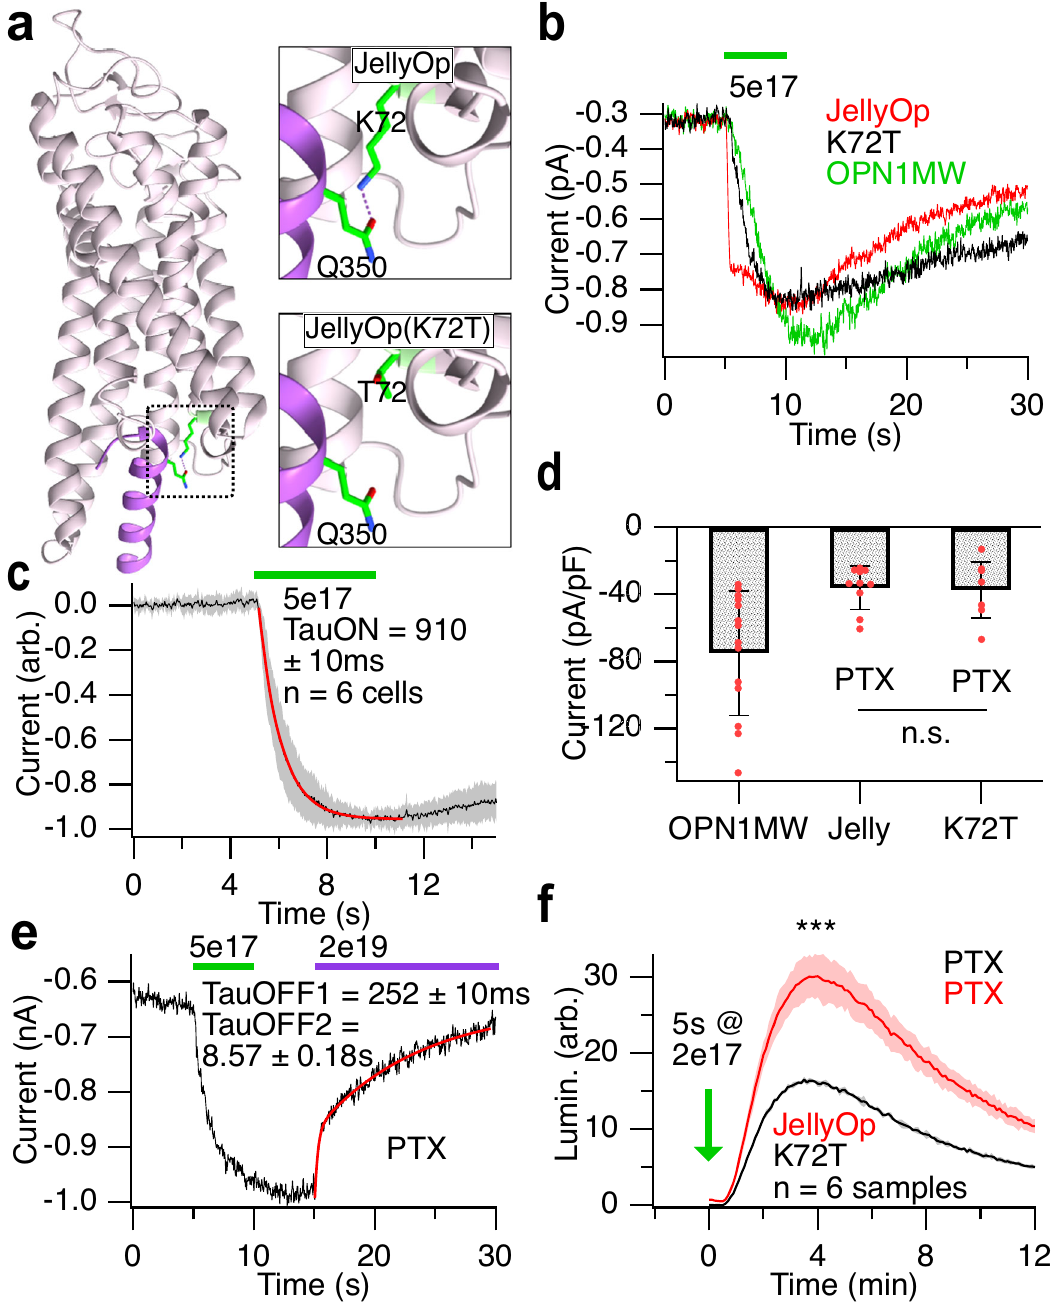
Fig.4|Weakeningtheaf fi nityofJellyOpforG α sbyintroducingtheK72Tpoint mutation con fi rms an uninterrupted JellyOp/G α s complex. a The crystal structure of rhodopsin/Mini-G α o (6FUF) with residues corresponding to L72 of bovine rhodopsin and G350 of G α o mutated to the corresponding residues in JellyOp and G α s (using ChimeraX) predicts a hydrogen bond interaction (low mag and top insert), which is no longer present when K72 is mutated to T (bottom insert). b GIRK currents activated by the K72T mutant have a delayed response onset, similar to that of OPN1MW. c The onset of JellyOp(K72T)-triggered GIRK currents have a signi fi cantly slower time constant than currents triggered by WT JellyOp ( p <0.001; error bands show mean±SD; see Fig. 1e). d Despite losing its transientresponsecomponent,theK72TmutantstilltriggersGIRKresponsesinthe